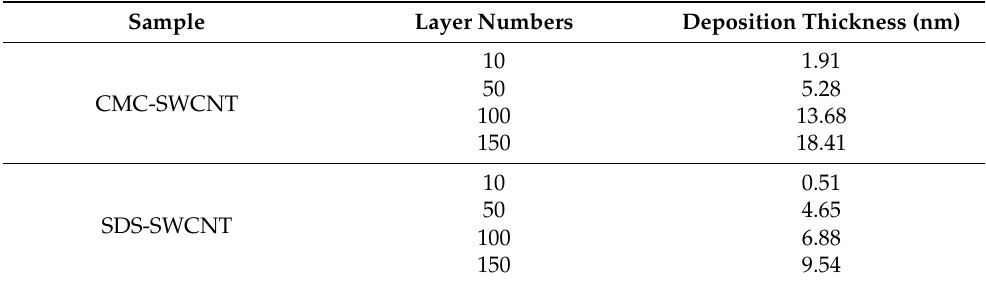
Table 2. Estimated average thicknesses of the CMC-SWCNT and SDS-SWCNT films in relation to the number of layers deposited, calculated using the effective attenuation length (EAL) method on the XPS data collected.